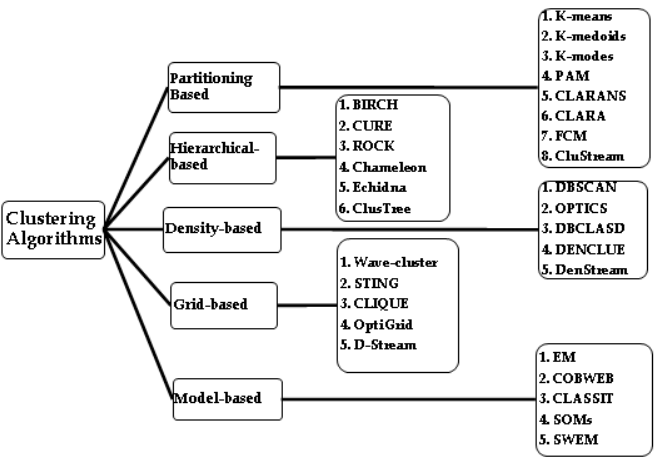
Figure 1. Categorization of Clustering Algorithms.